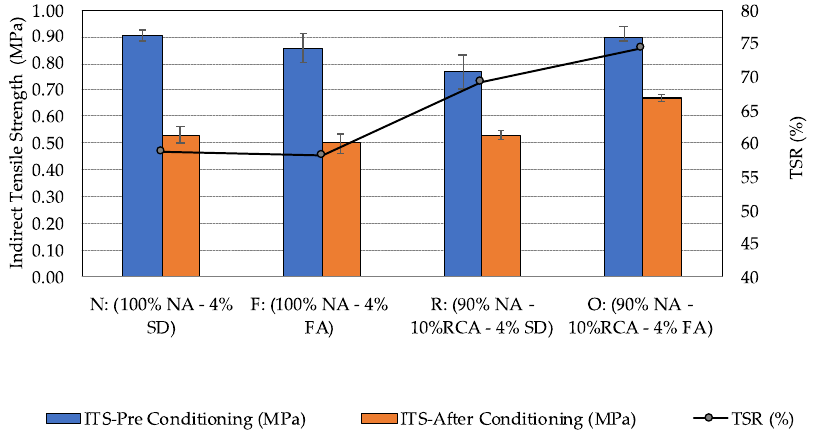
Figure 8. Average Marshall stability and Marshall Quotient at 25 °C of the four porous asphalt mixtures.